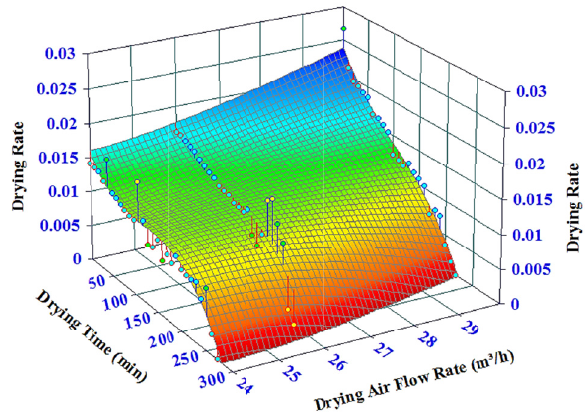
Fig. 14. Drying rate versus drying time of hawthorn at different drying air flow rates (drying air temperature=50 o C and vibration intensity=7.5 Hz)